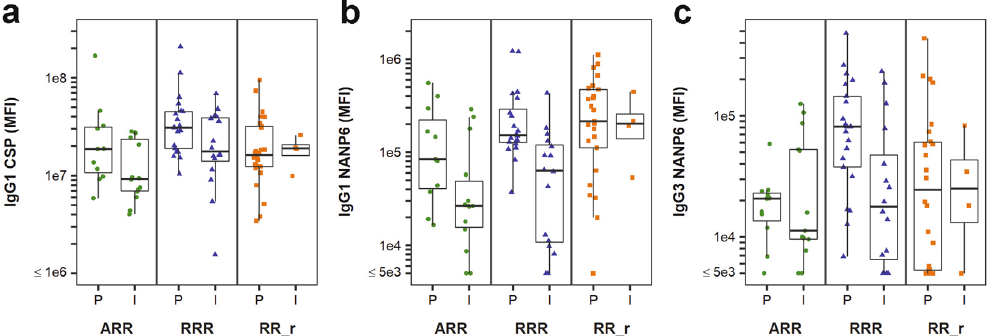
Fig. 3 Three IgG antibody subclass measurements individually associate with protection from sporozoite infection in RTS,S/AS01 studies. Antibody responses on the day of challenge (DOC) were compared for the protected (P) and infected (I) groups of RTS,S/AS01 vaccinees from the Ad35.CS.01 prime (ARR, green circles), standard dose (RRR, blue triangles), and delayed fractional dose (RR_r, orange squares) regimens from two different Phase 2a studies. The top antibody subclass measurements identi fi ed were CSP speci fi c IgG1 binding responses ( a , p = 0.017 and FDR-adjusted p = 0.091), NANP6 speci fi c IgG1 binding responses ( b , p = 0.001 and FDR-adjusted p = 0.021), and NANP6 speci fi c IgG3 binding responses ( c , p = 0.037 and FDR-adjusted p = 0.117). N = 25 for MAL-068 ARR, N = 21 for MAL-068 RRR, N = 16 for MAL-071 RRR, and N = 30 for MAL-071 RR_r. The lower and upper hinges of the boxplots correspond to the 25th and 75th percentiles, with a line at the median. The lower and upper whisker extends from the box hinges to the smallest and largest values, respectively, which are within 1.5 * IQR of the hinge (where IQR, the inter-quartile range, is equal to the distance between the 25th and 75th